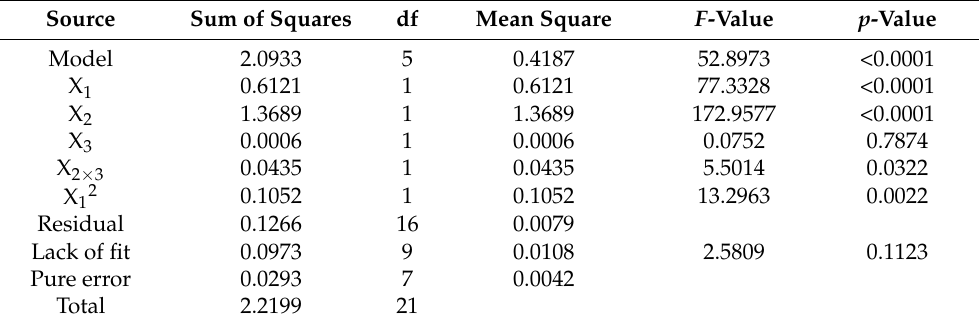
Table 3. Analysis of variance (ANOVA) of the reduced quadratic resolution model, using the coding X 1 = formic acid concentration ( v / v ) (%), X 2 = gradient slope (% min − 1 ) and X 3 = temperature ( ◦ C). Source Sum of Squares df